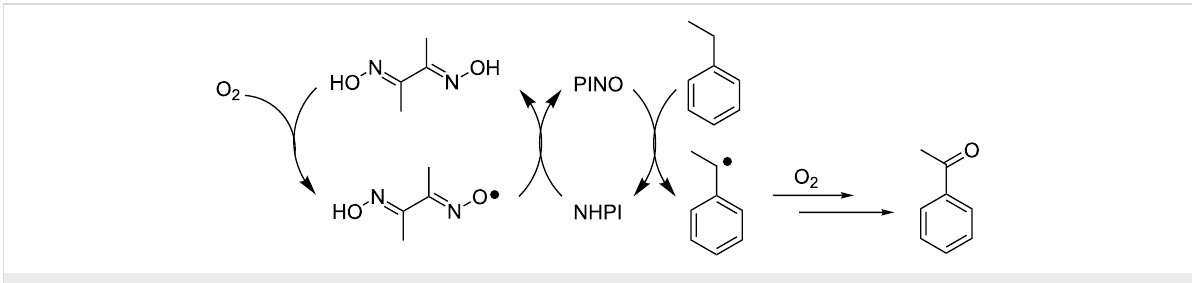
Scheme 25: NHPI/DMG-mediated organocatalytic